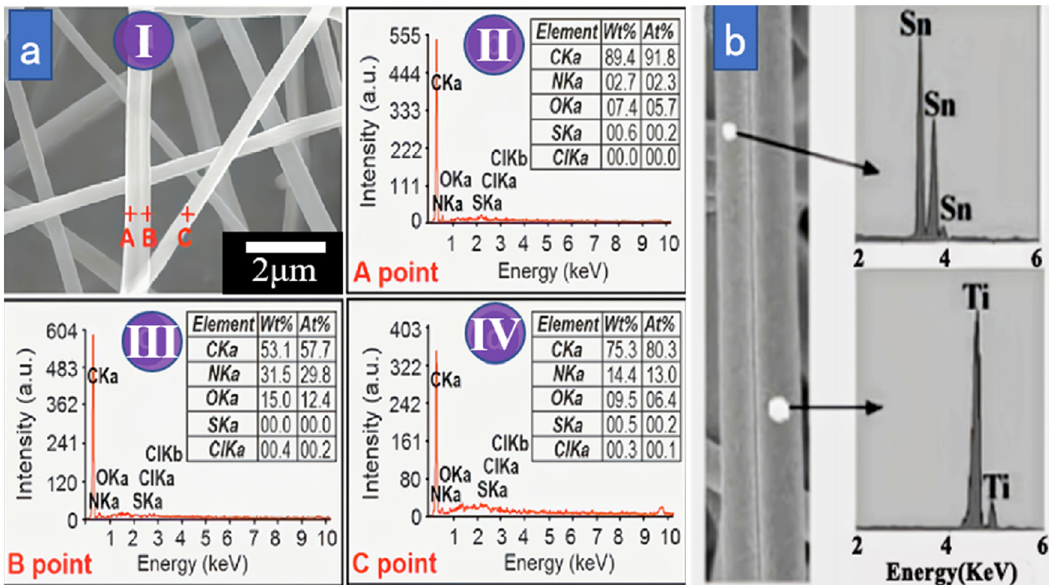
Figure 11: ( a ) Janus PVP K60/rhodamine b and EL100/ANS - NH4 fi ber, where I is fi eld emission scanning electron microscopy FESEM image of the Janus nano fi bers, II – IV are EDS spectra of the elements contained at points A, B, and C. ( b ) Typical EDS microanalysis on selected areas of a single TiO 2 /SnO 2 nano fi ber. ( a ) Reproduced with permission ( 130 ) Copyright 2015, Royal Society of Chemistry; ( b ) adapted with permission ( 131 ) Copyright 2007, American Chemical Society.